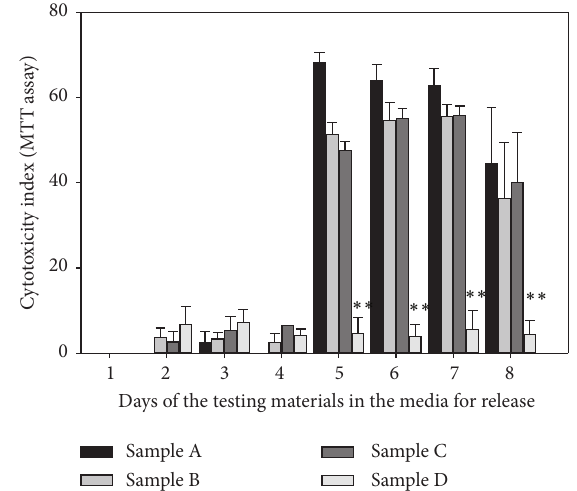
Figure 5: Cytotoxicity index was calculated based on MTT assay values to assess the cytotoxic influence of the release product from the testing materials (see Section 2 for calculation formula). Delayed cytotoxic effects were obvious on the texting samples except sample D ( ∗∗ 𝑃 < 0.01